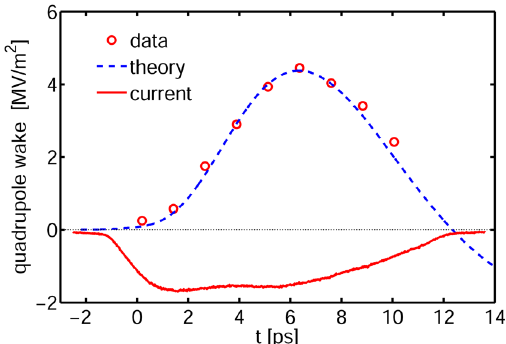
FIG. 8. Measured (red circles) and simulated (blue dashed line) time-dependent quadrupole wakefields with the gap of down- stream CS set at 3.2 mm. The beam longitudinal distribution is also shown in red solid line.